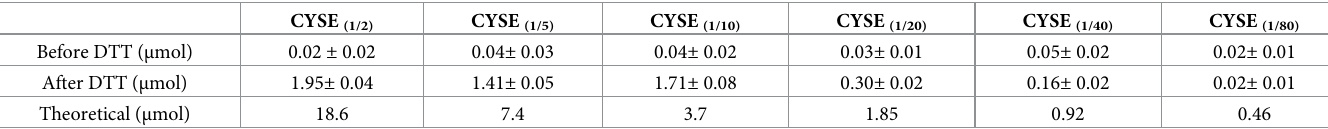
Table 1. Amounts of the thiol groups in a 10 mg dried gel sample before and after DTT treatment and by theoretical